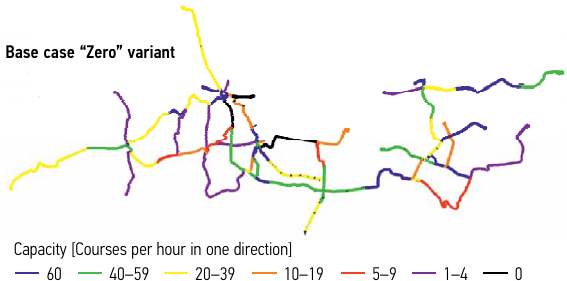
Fig. 11. Base case – the current capacity of tramway network